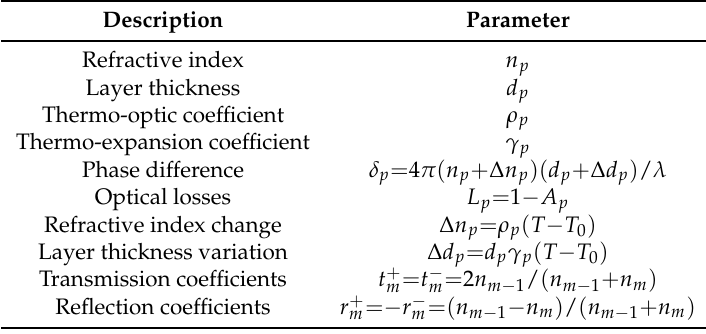
Table 1. List of parameters used in equation 1 for the m -th interface and the p -th layer (Figure 1).